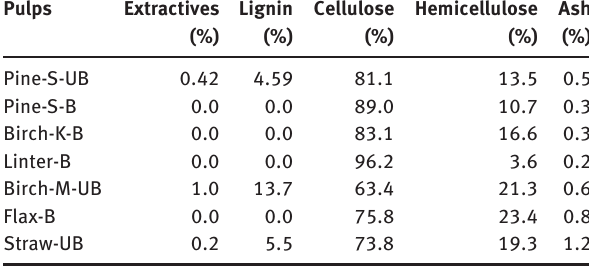
Table 2 Chemical composition and ash content of pulps